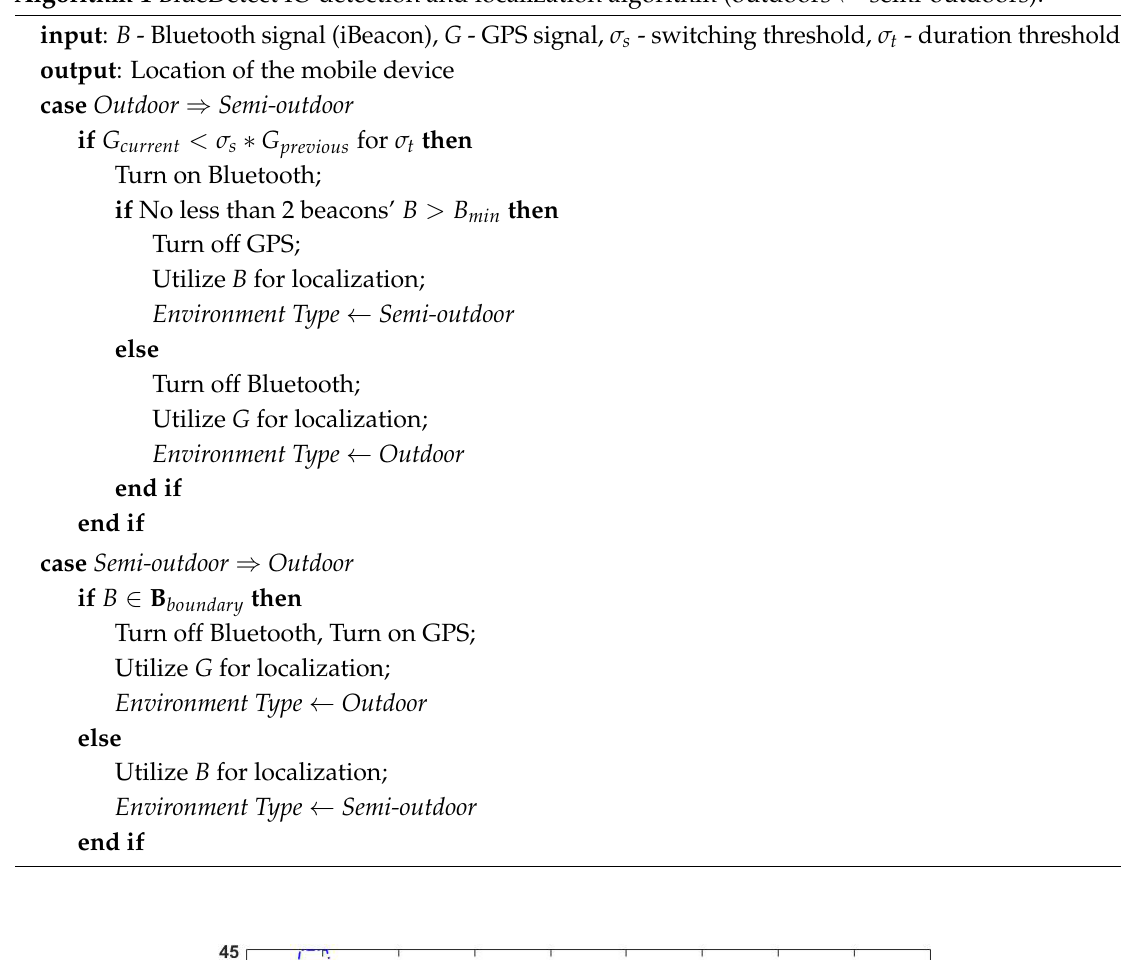
Algorithm 1 BlueDetect IO detection and localization algorithm (outdoors (cid:10) semi-outdoors).